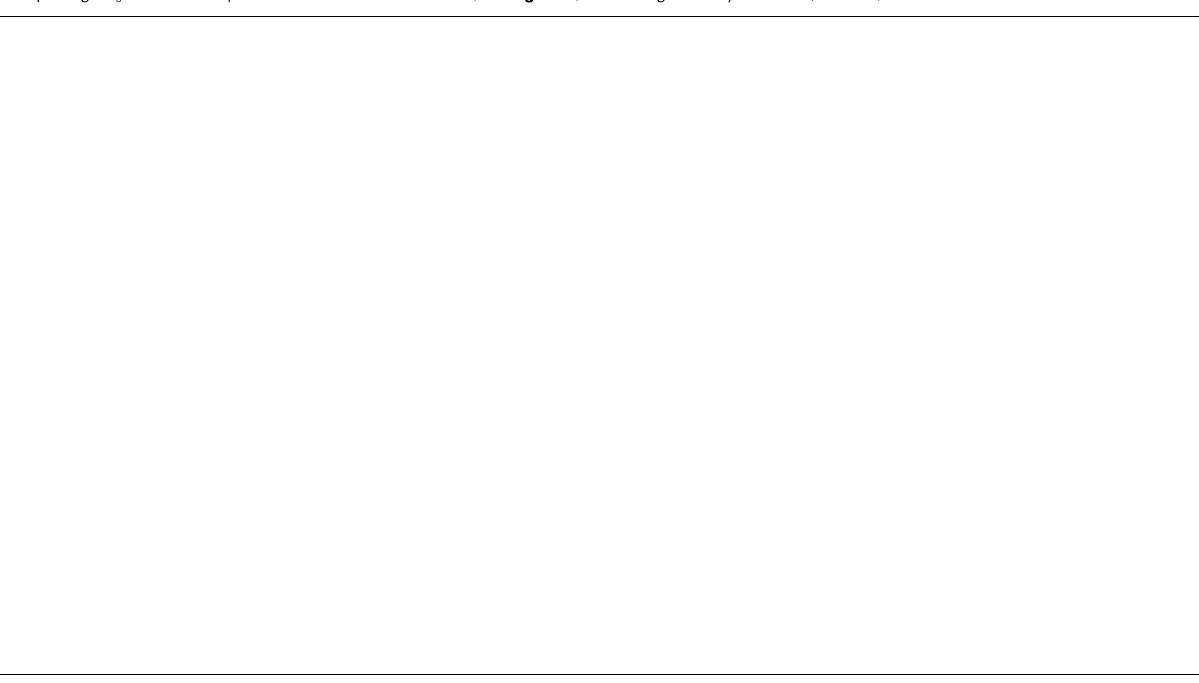
lotus (black bar) and tomato (gray bar). Semi-quantitative RT PCR of EIN3 targets of (I) lotus and (J) tomato roots after silver ion inhibition for water control (1) untreated control (2), Ag + untreated control (3), LC-treated (4), and Ag + LC-treated (5) roots (from left to right). Bottom panel represents PP2A and 18S rRNA expression for lotus and tomato, respectively.The values are the mean ± SE ( n = 6).The data was analyzed using one way ANOVA followed by Fisher’s least significant difference and bars that do not share letters are significantly different ( P < 0.05) from each